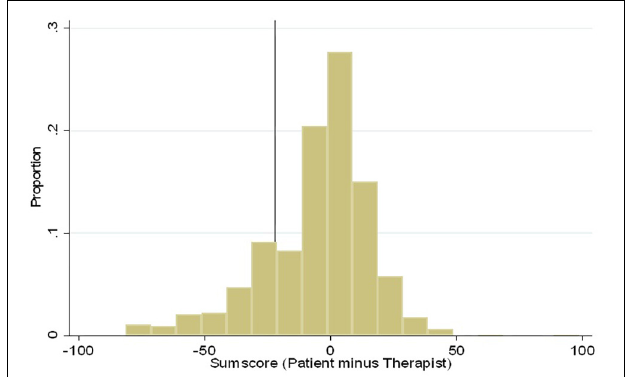
FIGURE 1 | Distribution of SDM dyadic deviation values among the patient-therapist pairs in the study n = 953.